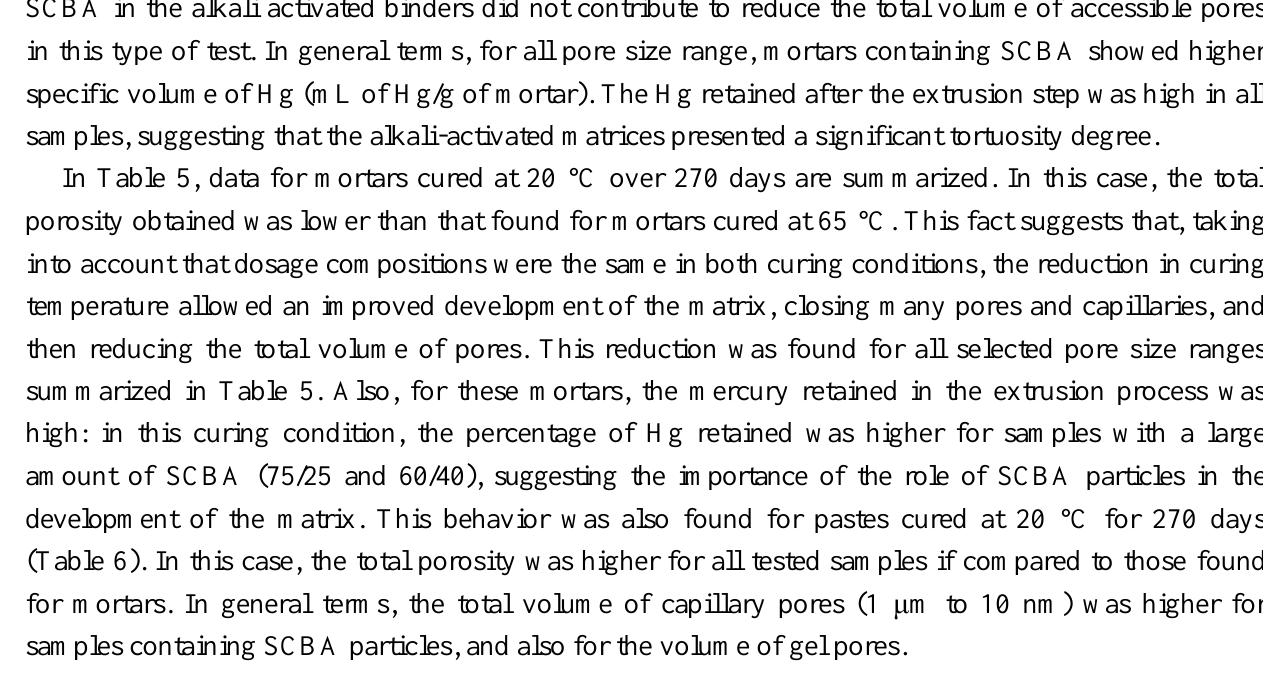
Table 4. MIP results for mortars cured 3 days at 65 °C.